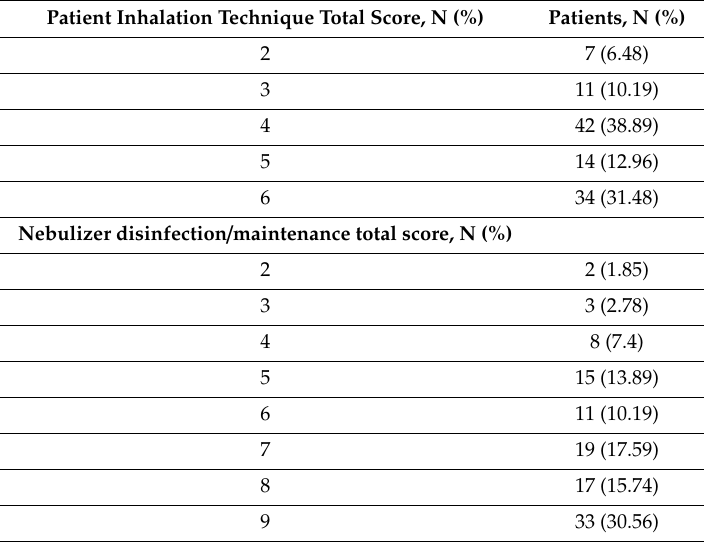
Table 1. Technique and maintenance total